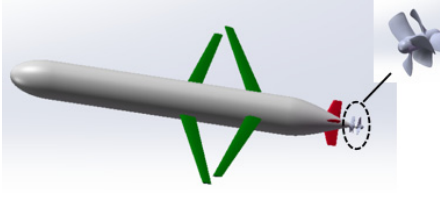
Figure 29. Model of the AUG with the CRP.